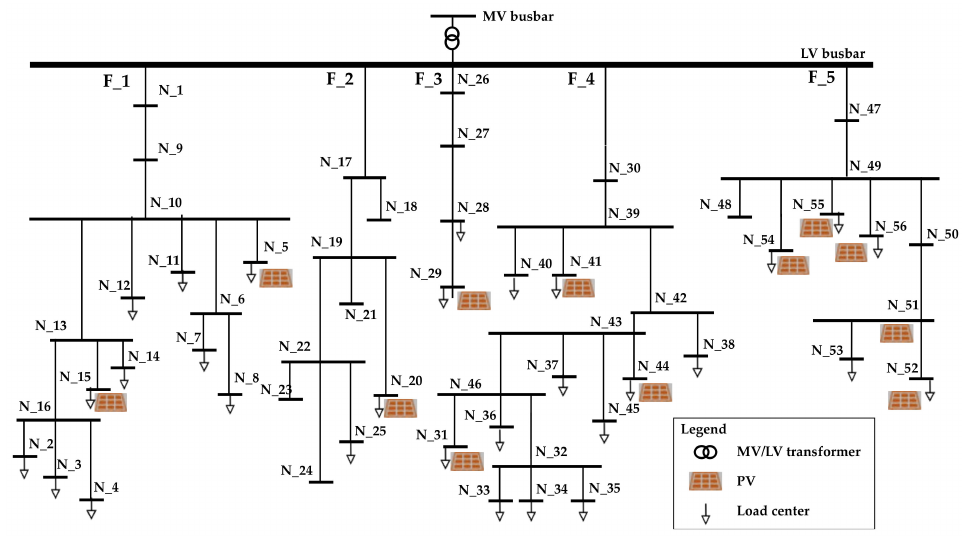
Figure 17. Test network.